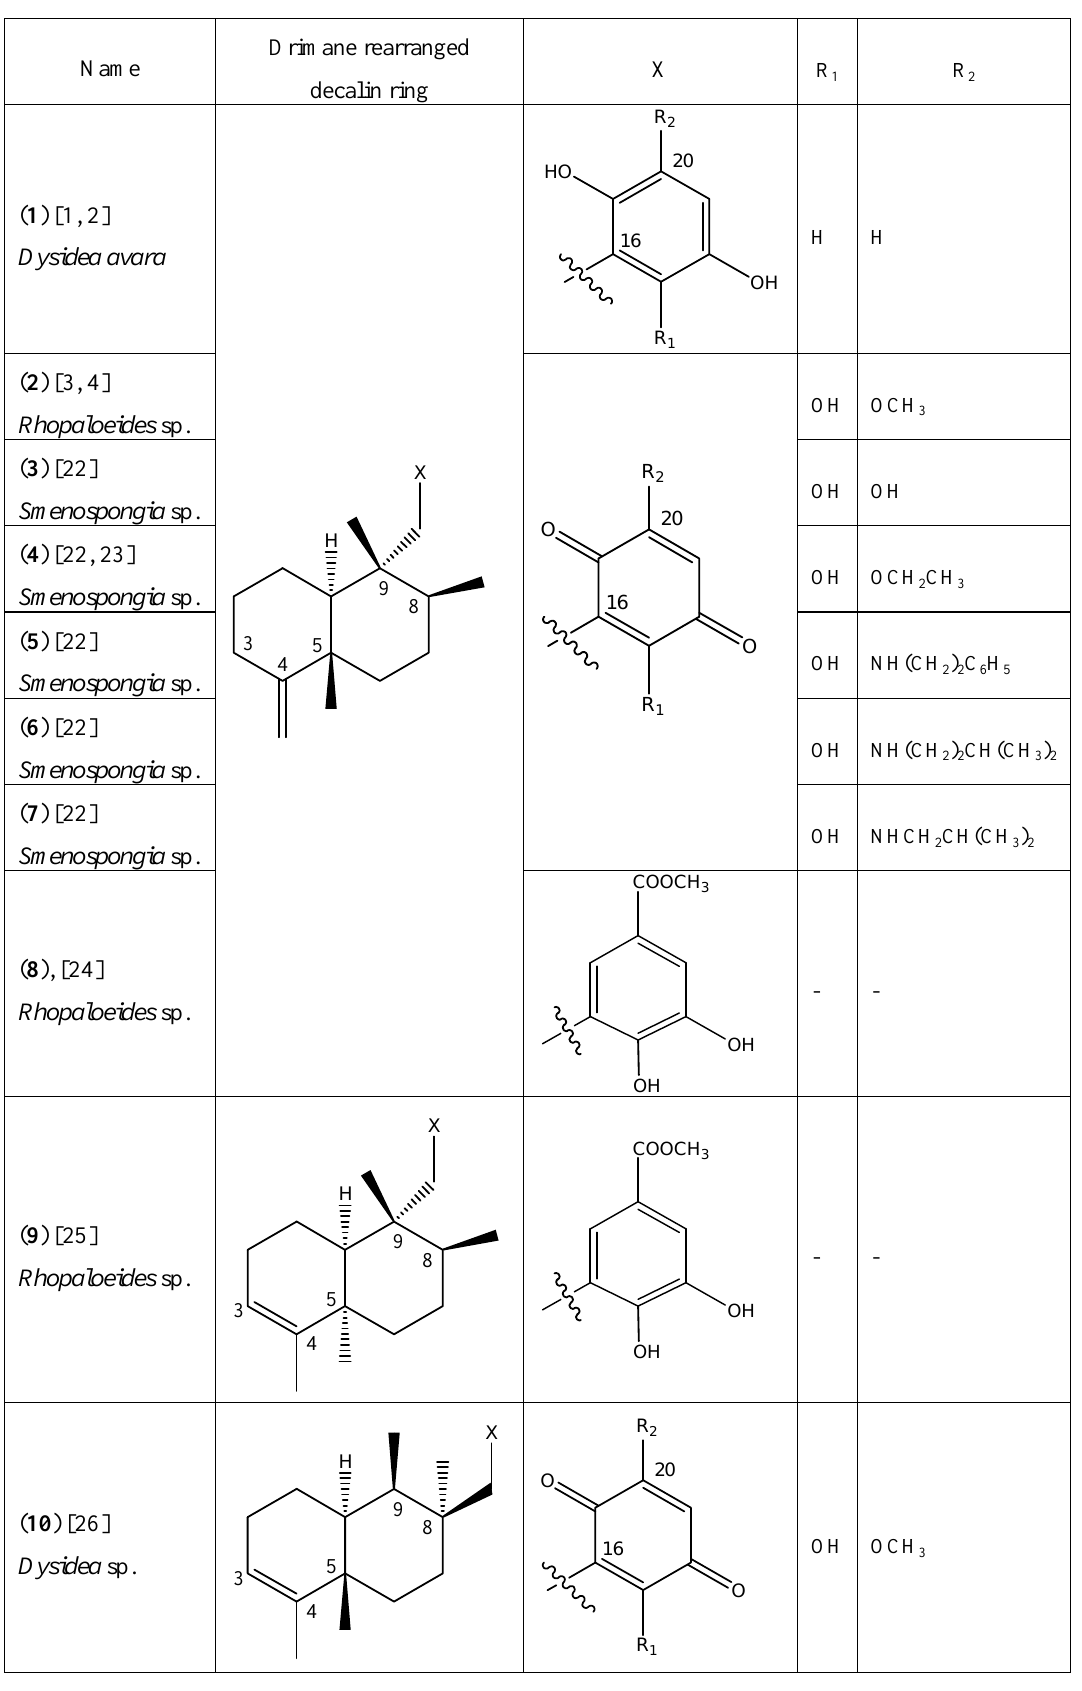
Table 1. Structures of avarol, 1 , the sesquiterpene hydroxyquinones/ amino- quinones/hydroquinones 2 – 9 and bolinaquinone, 10